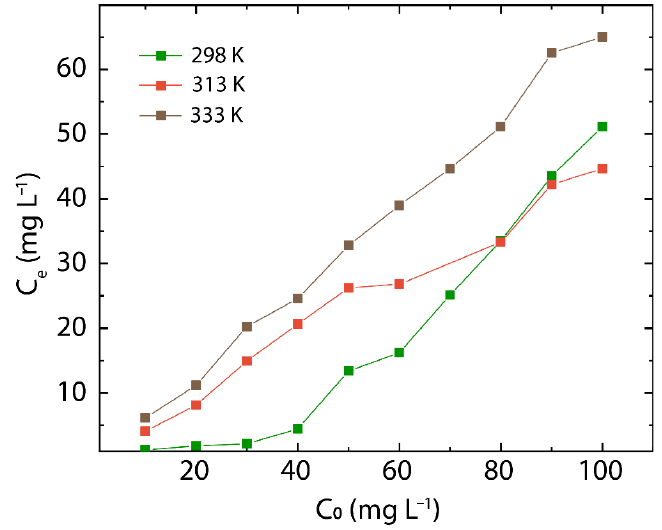
Figure 8. Effect of the initial concentration by analyzing 𝐶 𝑒 as a function of 𝐶 0 at 298, 313, 333 K. At higher equilibrium concentrations ( ≥ 90 mg L −1 ), a deviation from linearity does occur at 313 K (red markers) and 333 K (brown markers). Remarkably, at low initial concentrations ( ≤ 10 mg L −1 ), the equilibrium concentrations at 298 K (green points) and 313 K (red points) fall in the ppb range.